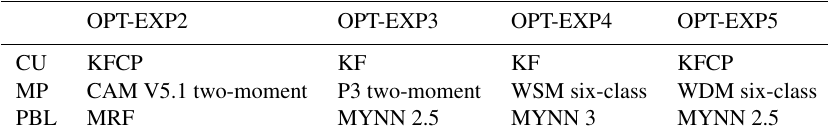
Table 6. The selected schemes for OPT-EXP2, OPT-EXP3, OPT-EXP4, and OPT-EXP5.